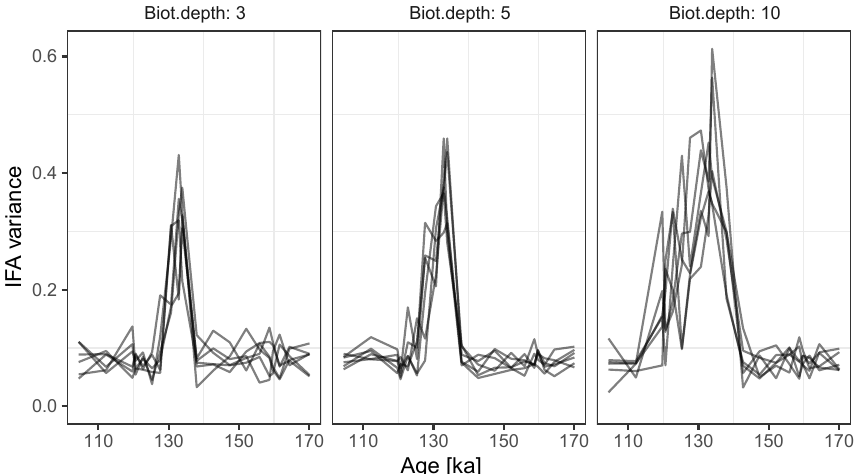
Figure 10. Variance in simulated δ 18 O measured on sets of 20 individual foraminiferal tests. Lines show six replications with the same